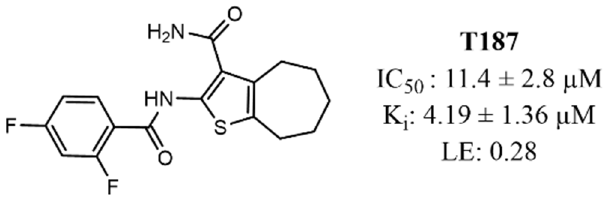
Figure 1. Chemical structure and biological data for T187 . IC 50 represents the compound concentra- tion necessary to reduce by 50% the ADP formation in the ADP-Glo Assay; K i is the AKT1 inhibition constant; Ligand efficiency (LE) refers to the potency of a compound averaged by its non-hydrogen atom count (LE = 1.4 pIC 50 /N, where N is the number of heavy atoms). LE is expressed as units of kcal mol − 1 N − 1 .